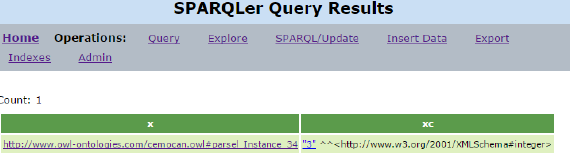
Figure. 5. Result of the third